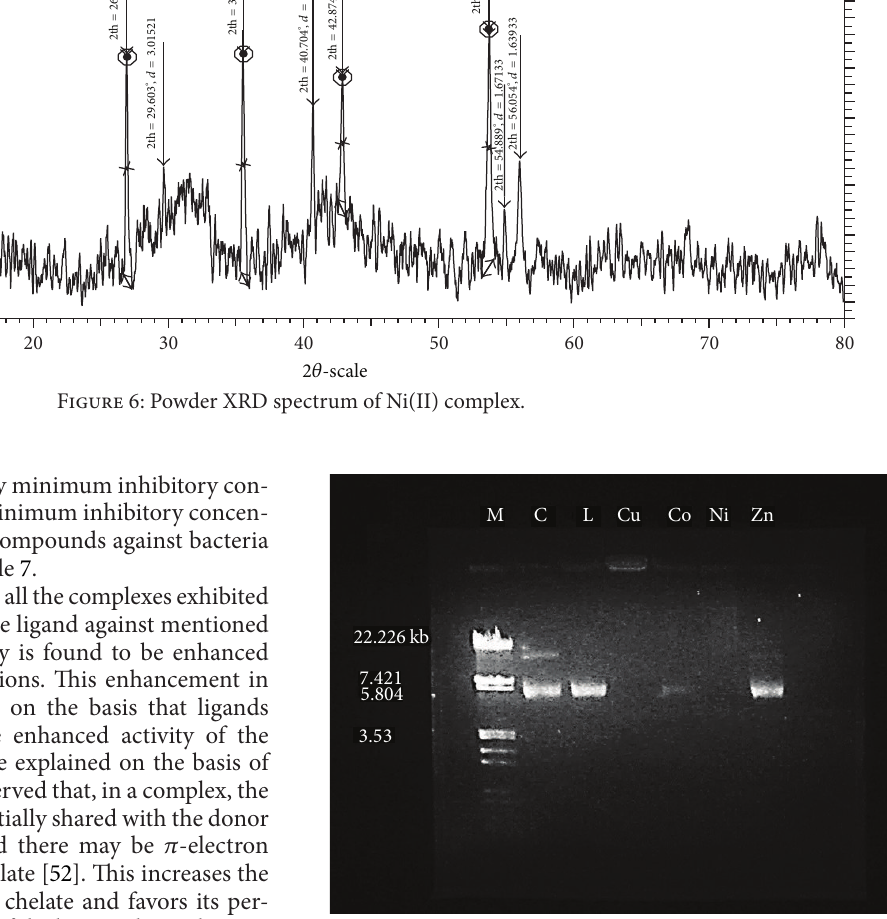
Figure 7: DNA cleavage on plasmid pBR 322: M: Standard DNA, C: Control DNA (untreated pBR 322), L: Schiff base ligand, Cu: Cu(II) complex, Co: Co(II) complex, Ni: Ni(II) complex, and Zn: Zn(II)